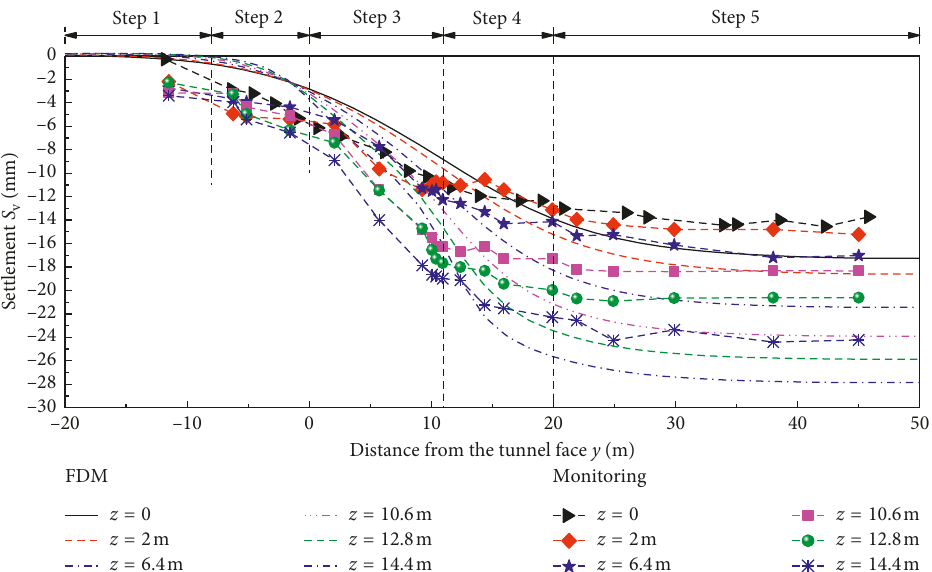
Figure 15: Vertical displacements in the longitudinal section of different